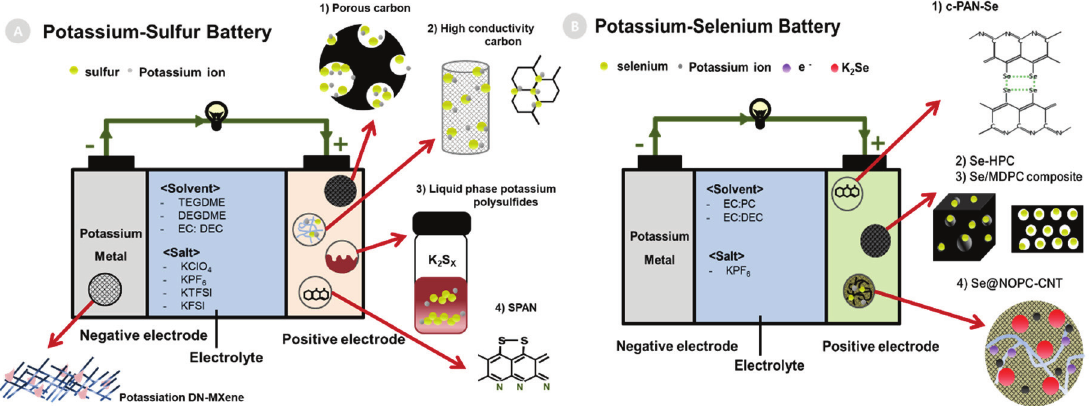
Figure 1. Schematic of rechargeable ( A ) potassium–sulfur (K–S) battery and ( B ) potassium–selenium (K–Se) battery.